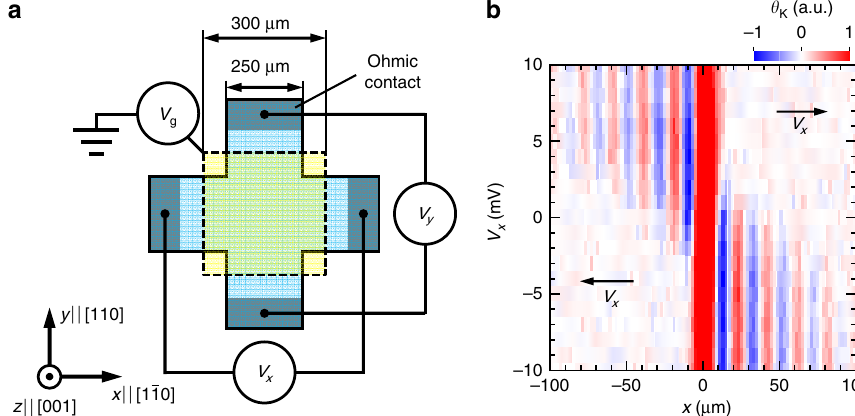
Figure 1 | Creation of drift spin flows in a cross-shaped device. ( a ) Schematic of top view of our samples. ( b ) In-plane electric field dependence of spin distribution in steady state in 25-nm-thick QW at V g ¼ (cid:2)